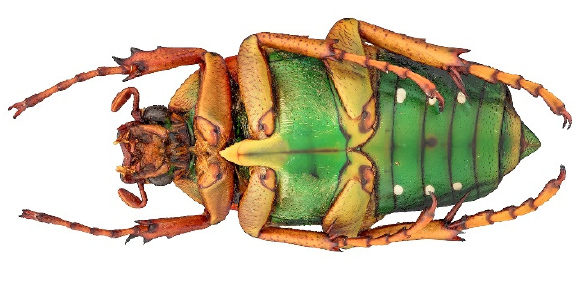
Figure 6. Textured 3D model of the Spotted Flower Beetle.